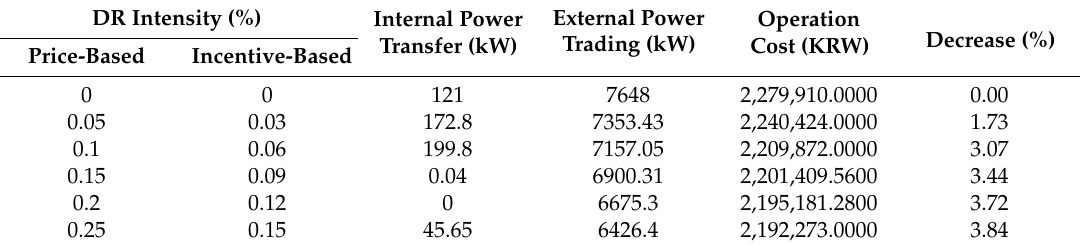
Table 5. Effect of DR intensity on power transfer and operation cost.